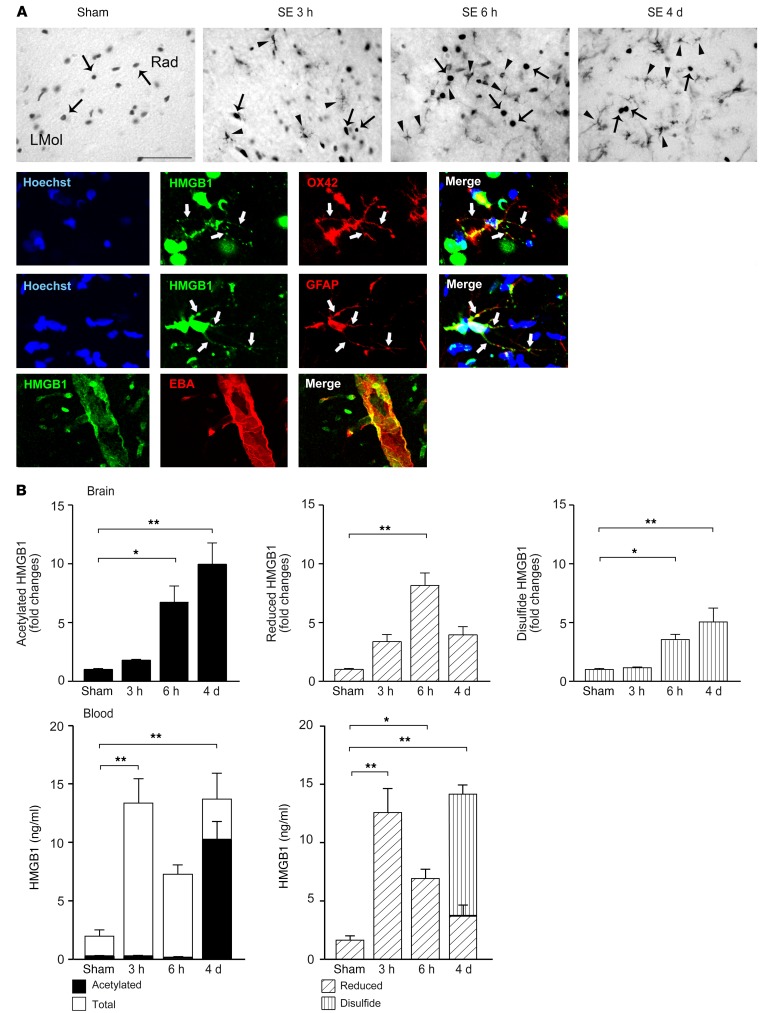
Brain and blood HMGB1 measurements during epileptogenesis evoked by electrical SE in adult rats.(A) Representative photomicrographs of hippocampi from control rats (sham) or rats at 3 hours, 6 hours, and 4 days after SE (n = 5 each group). Top row shows HMGB1 immunoreactivity in cell nuclei (arrows) or in cytoplasm of glial cells (arrowheads). Immunofluorescence panels show localization of HMGB1 signal (green) in OX-42–positive microglia (red), GFAP-positive astrocytes (red), and EBA-positive endothelial cells (red); colocalization signal is depicted in yellow (merge). White arrows depict cytoplasmic staining. Hoechst-positive nuclei are shown in blue. Rad, stratum radiatum; LMol, stratum lacunosum moleculare. Scale bars: 25 μm (top row); 20 μm (bottom row; immunofluorescence panels). (B) Levels of HMGB1 isoforms in brain tissue (hippocampus) and corresponding blood of rats during epileptogenesis. Data are shown as mean ± SEM (n = 5 each group). Dot plots are shown in Supplemental Figure 4. *P < 0.05; **P < 0.01, Kruskal-Wallis test (referred to both isoforms in each bar). Blood acetylated and disulfide HMGB1 levels at 4 days are significantly different from corresponding 3-hour and 6-hour levels (P < 0.01).